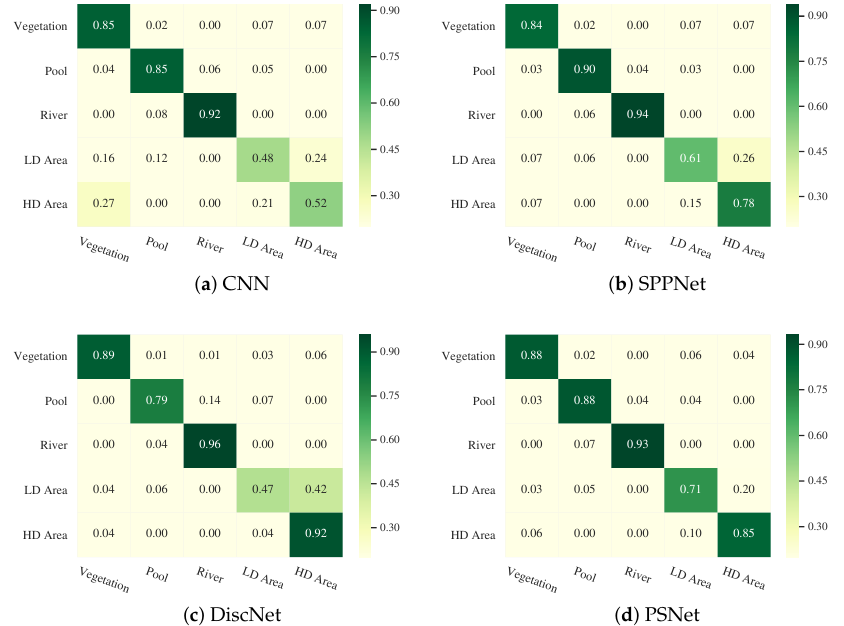
Figure 14. Confusion matrices for the Guangdong dataset.